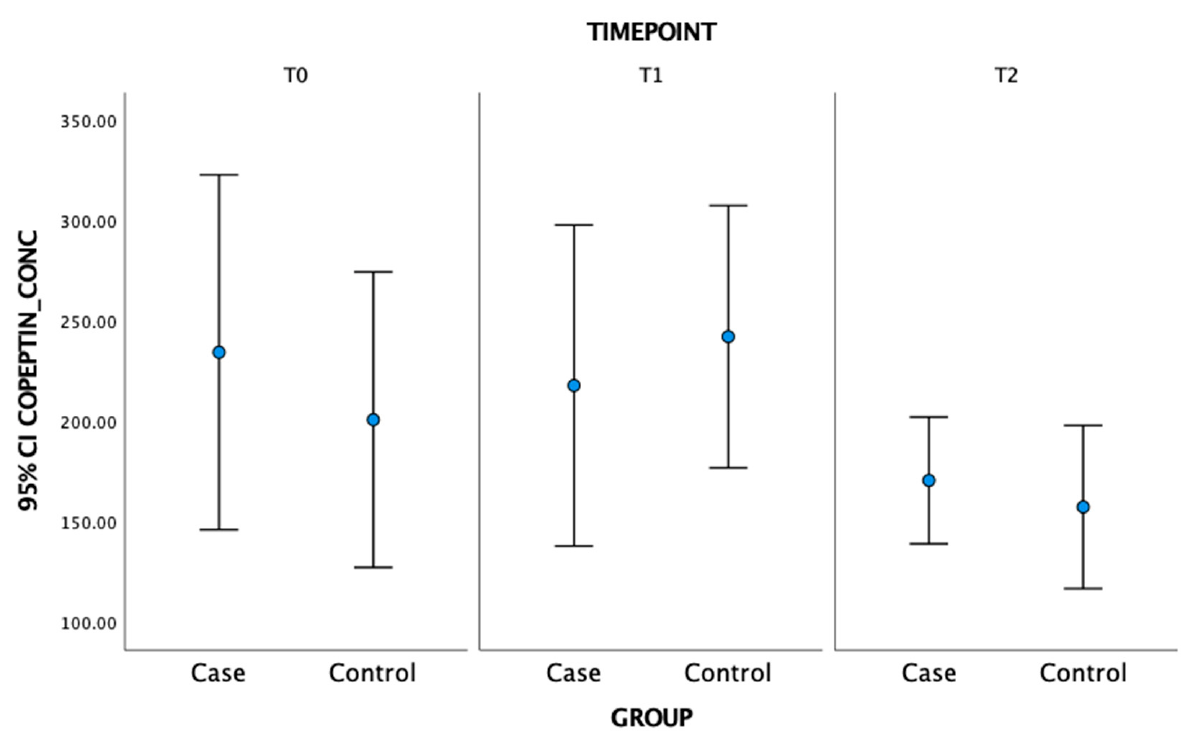
Figure 1. Mean concentrations of copeptin (pg/mL) measured in saliva before (T0), immediately (T1) and 10 min after (T2) separation from the owner in dogs from both groups (N = 25). No group differences across the timepoints were detected ( p > 0.05).